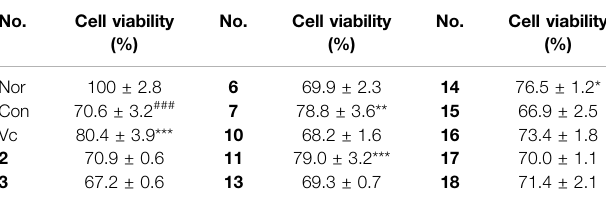
TABLE3| CellviabilitiesofUVBinducedHaCaTcellspretreatedwith 2 , 3 , 6 , 7 , 10 , 11 , 13 – 18 . No.